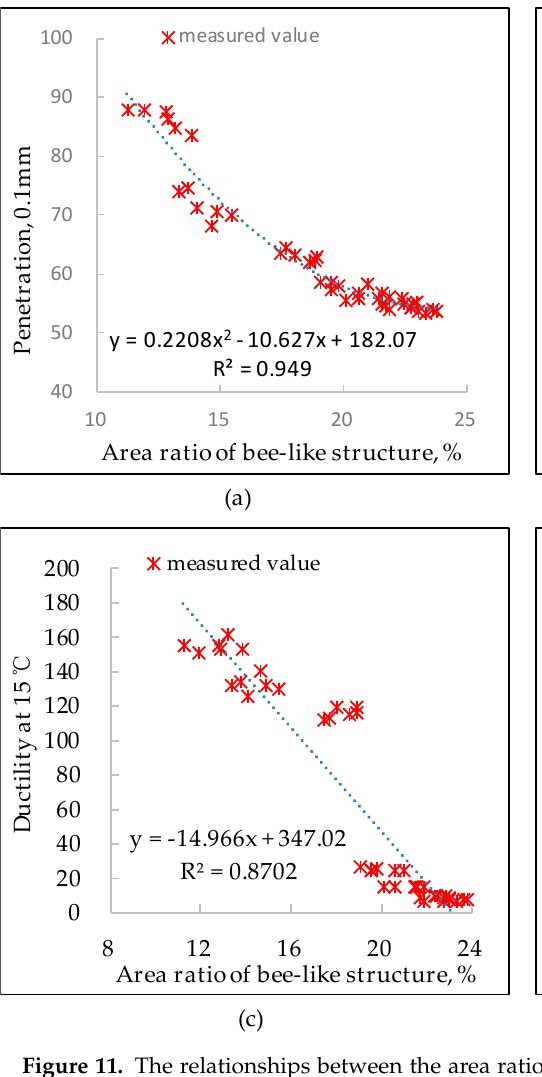
Figure 11. The relationships between the area ratio of the bee-like structure and technical indexes. ( a ) penetration at 25 °C; ( b ) softening point; ( c ) ductility at 15 °C; ( d ) viscosity at 60 °C.